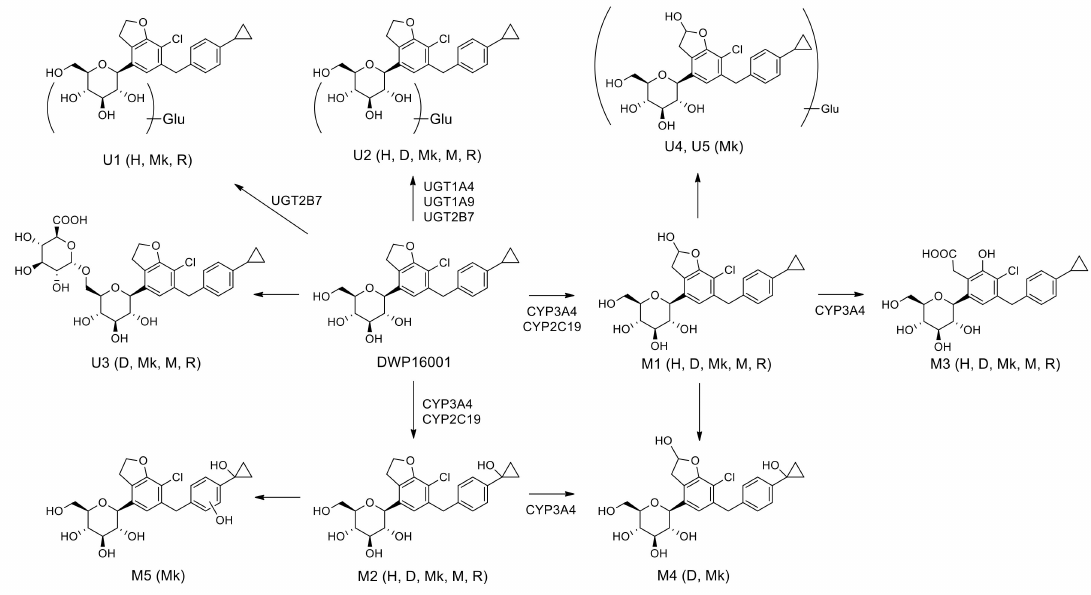
Figure 8. Possible in vitro metabolic pathways of DWP16001 in human, dog, monkey, mouse, and rat hepatocytes. H: human; D: dog; Mk: monkey; M: mouse; R: rat; Glu: